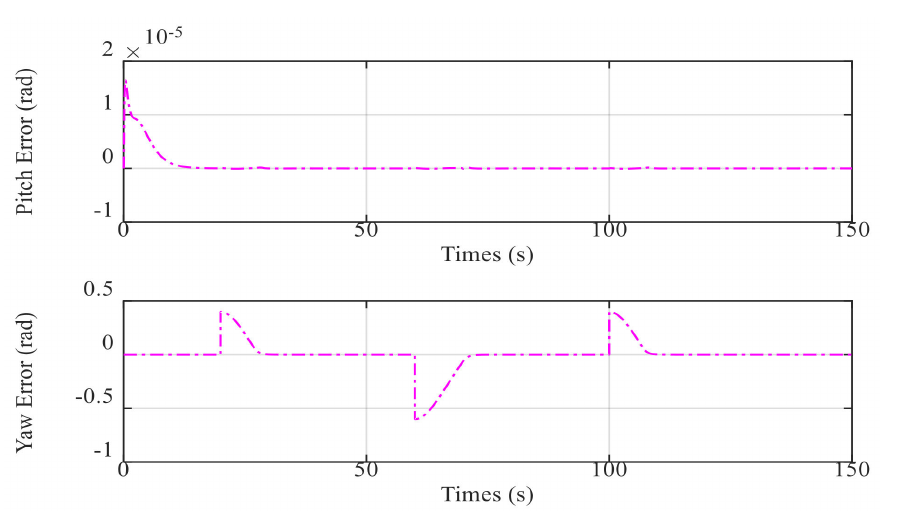
Figure 10. The feedback error of the MJ-AUV.